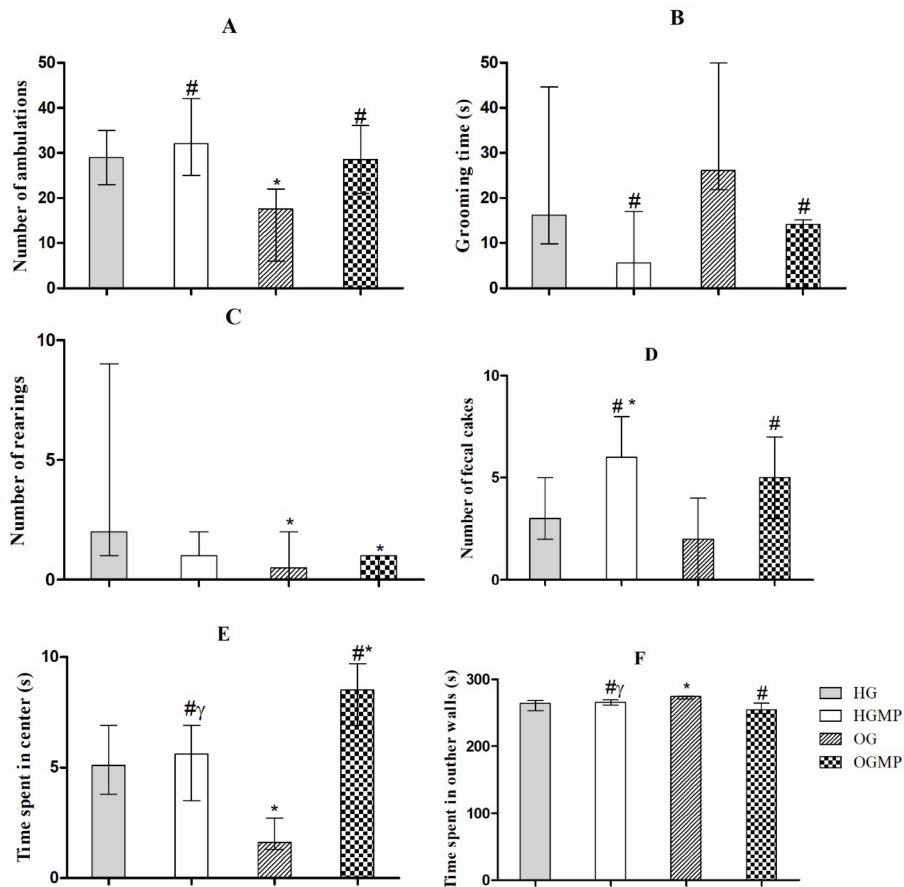
Figure 3. Results of the open field test regarding the number of ambulation ( A ), grooming time ( B ), rearing number ( C ), number of fecal cakes ( D ), time of spent in center ( E ) and time spent in outher walls ( F ) evaluated in healthy and obese rats treated or not with MP seed extract. Data presented as median (minimum and maximum). Kruskal-Wallis test, Dunn post-hoc ( p ≤ 0.05). * di ff ered from HG; # di ff ered from OG; γ di ff ered from OGMP.